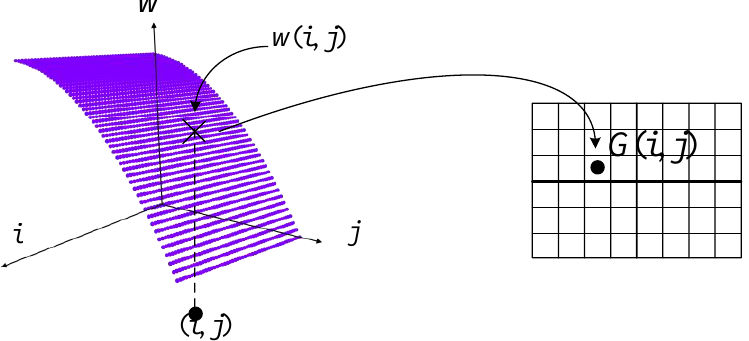
( i , j ) and allocate ε with probability ρ